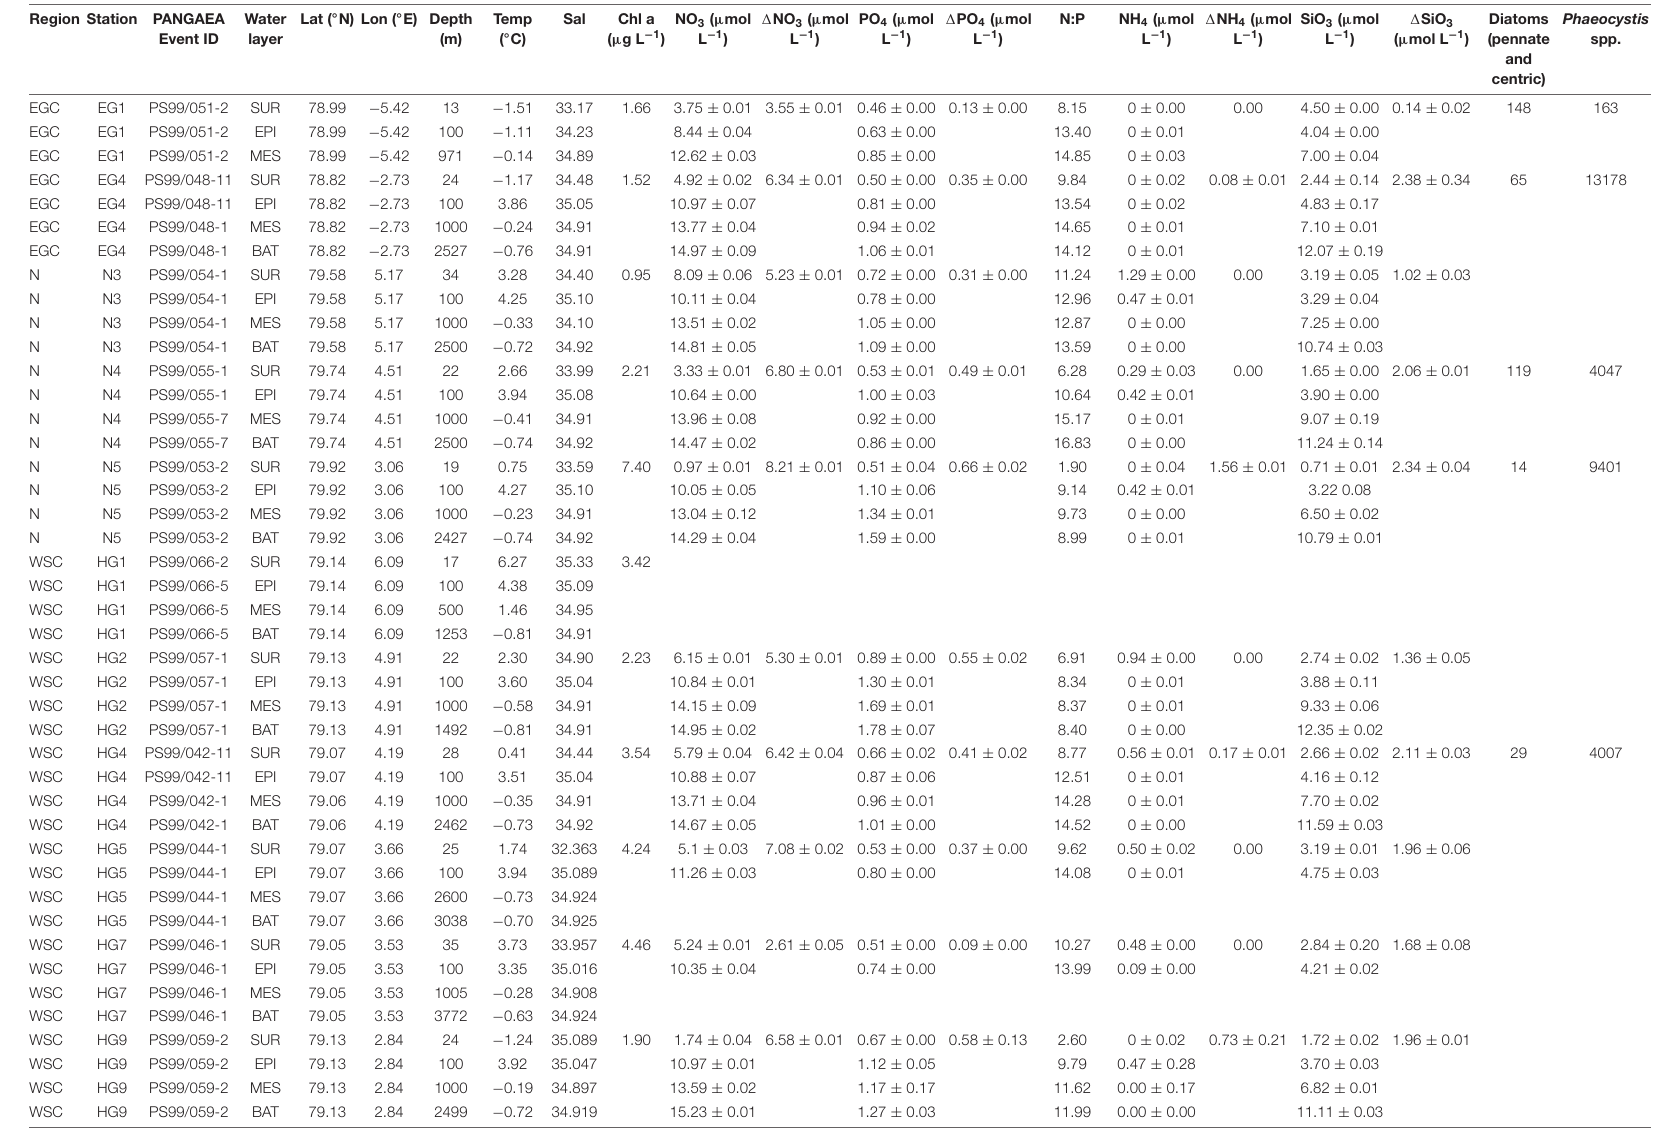
TABLE 1 | Environmental parameters measured at different stations and microscopy counts (cells mL − 1 ) of diatoms and Phaeocystis spp. Region Station PANGAEA Event